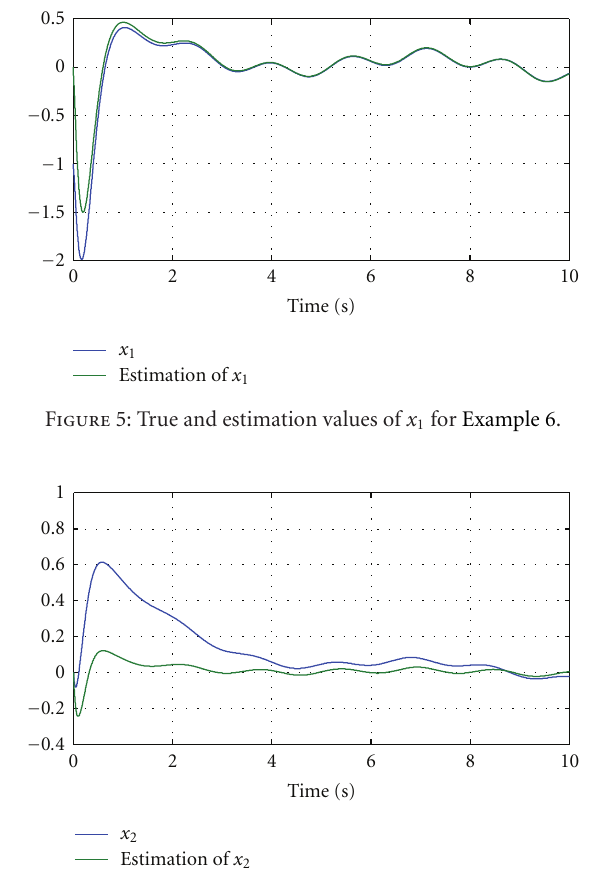
Figure 6: True and estimation values of x 2 for Example 6.